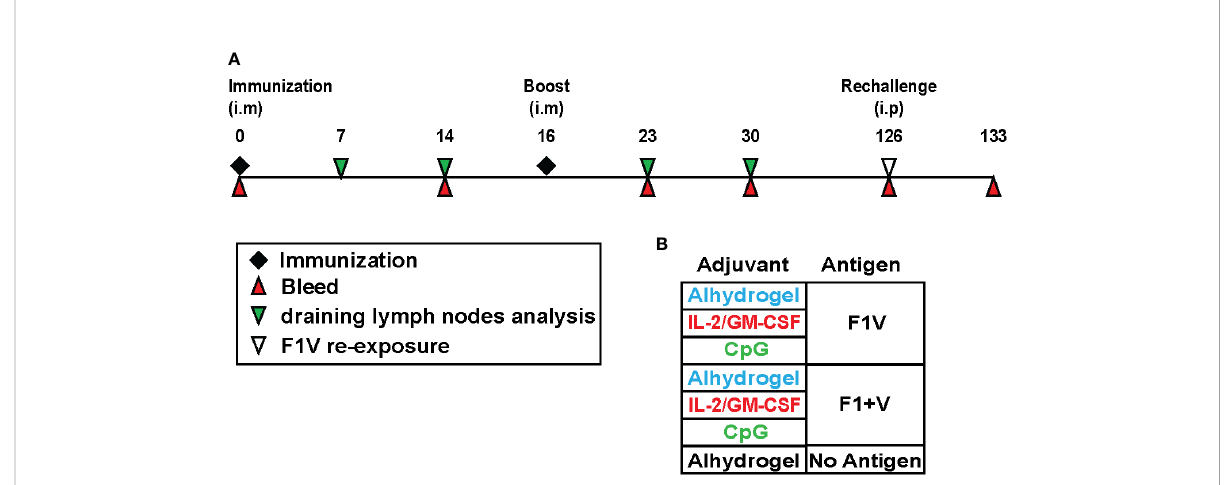
FIGURE 1 Recombinant plague antigen vaccine study design to evaluate germinal center B cell and T cell responses and long-lived antibody responses. (A) Schematic showing the study timeline and timepoints for immunization, draining lymph node collection, and blood collection from immunized mice. Mice were immunized and boosted intramuscularly with antigen and adjuvant at day 0 and day 16. At day 126, mice were injected intraperitoneally with F1V antigen (no adjuvant) and the antibody recall response was measured 7 days later (day 133). (B) Table shows the various antigen + adjuvant vaccine